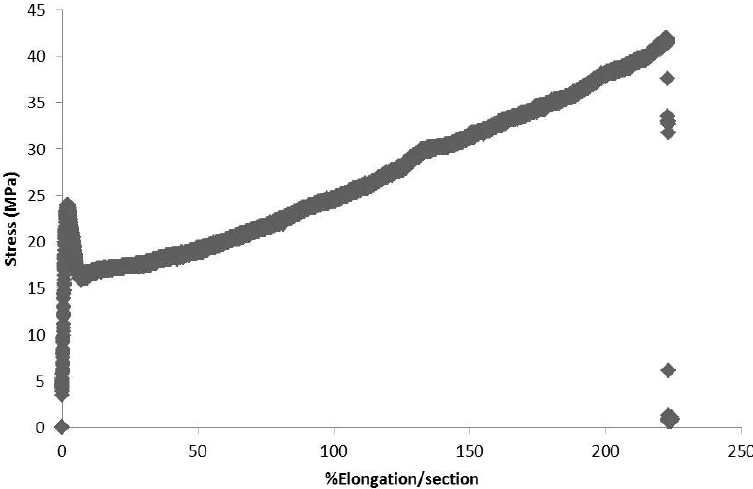
Figure 1. Example of a diagram obtained from the tensile test of the